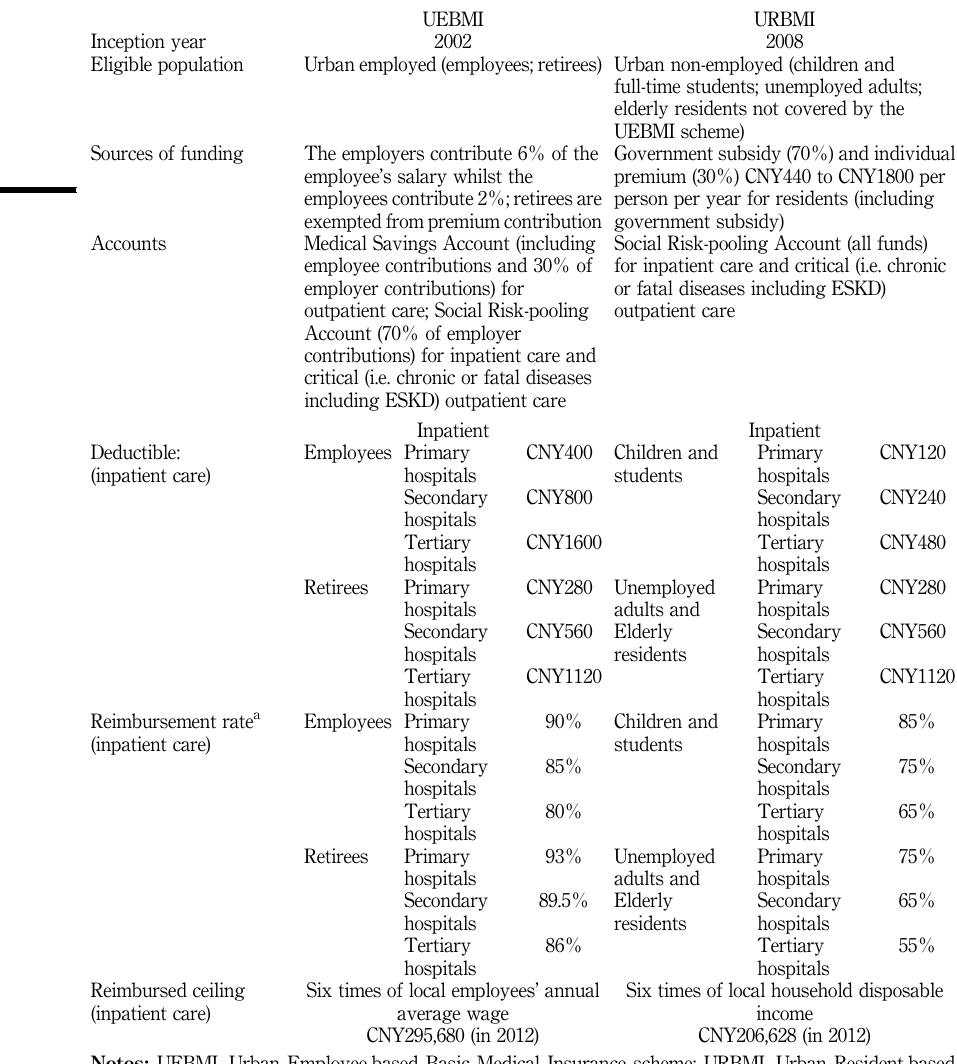
Table I. Comparison of UEBMI and URBMI policies for CKD patients in Guangzhou in